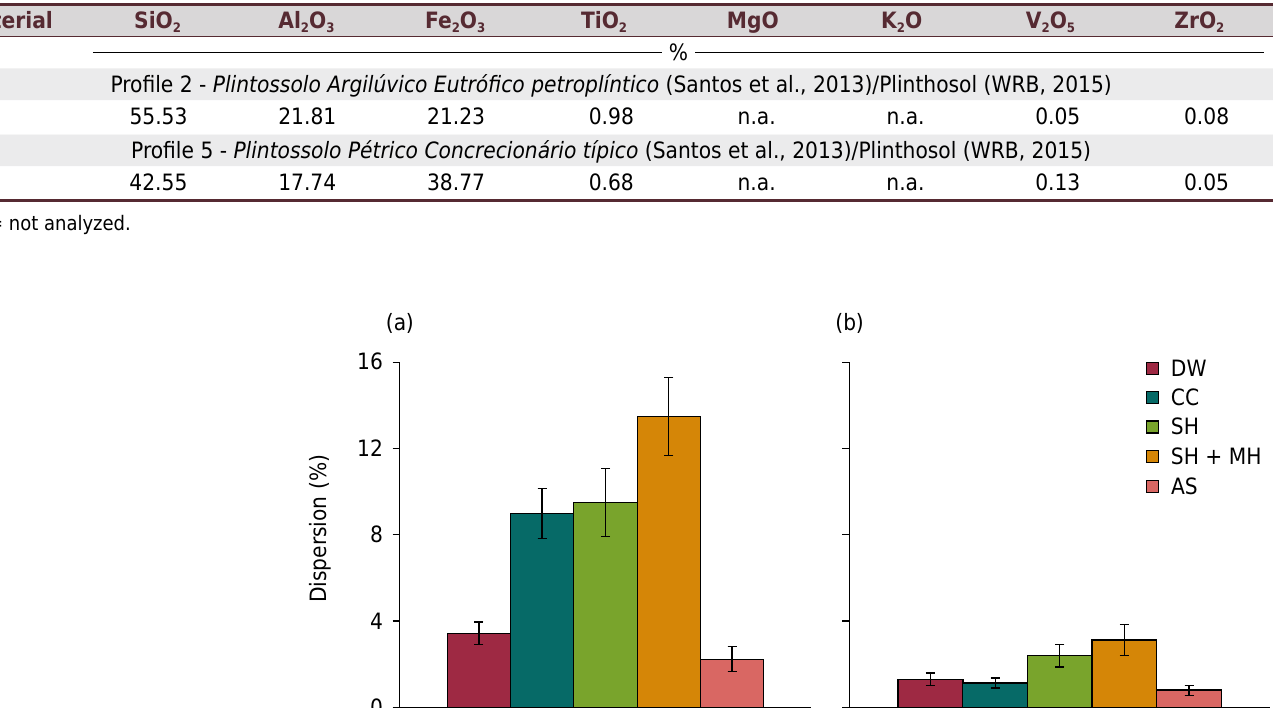
Table 4. Main chemical components of plinthite (PL) and petroplinthite (PP) determined by X-ray fluorescence spectrometry (XRF) for each studied profile Material